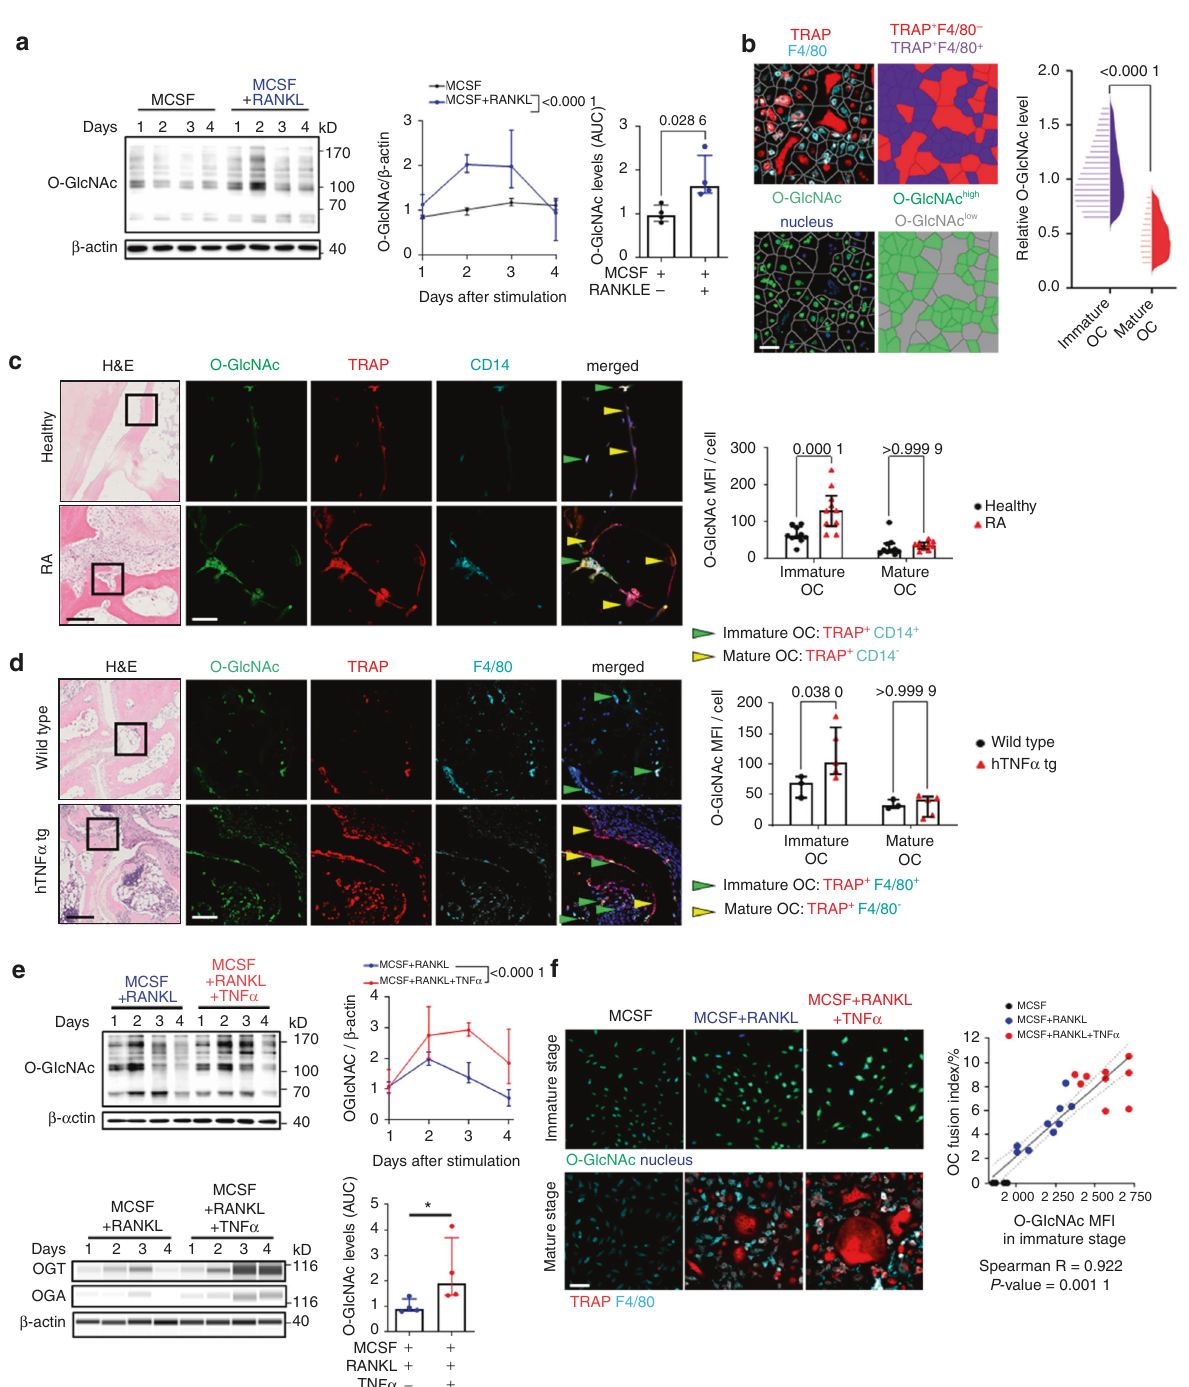
Fig. 1 Dynamic regulation of protein O-GlcNacylation during osteoclastogenesis. a Western blot analysis of protein O-GlcNAcylation during osteoclastogenesis in vitro ( n = 4 per group). Representative images and quanti fi cation of the changes in the levels of O-GlcNAc normalized to β -actin over time are shown. b Representative Voronoi-tessellated cellomics images of in vitro osteoclastogenesis and cellomics analysis of O-GlcNAcylation levels in immature and mature osteoclasts (OC) ( n = 21025 cells in total). Representative histology and confocal microscopic images of O-GlcNAc, TRAP, and CD14 triple stainings in bone tissues from healthy donors and RA patients ( c ) or wildtype and hTNF α tg mice ( d ). Semi-automated, blinded quanti fi cation of O-GlcNAcylation in immature and mature OC in synovial tissue sections ( n = 10 sections per group). Immature OC (green) and mature OC (yellow) are marked with arrows. e Representative blots of Western blots and ProteinSimple Wes immunoassay of O-GlcNAcylation, OGT, and OGA expression ( n = 4 per group). f Representative cellomics images of protein O-GlcNAcylation in immature OC and its correlation (Spearman) with osteoclastogenesis. The OC fusion index represents the proportion of the nuclei in mature OCs ( n = 9 per group). Bar graphs are shown as median ± IQR. Linear regression and its 95% con fi dence interval (dashed line) are presented in the correlation plots ( f ). Horizontal scale bars are represented as 50 µm in IF images or 200 µm in H&E images. Statistical signi fi cance was determined by Mann-Whitney U-test ( a, b, e ) or two-way ANOVA ( c , d ). P -values and Spearman ’ s ρ are shown in the graphs. AUC area under the curve, OC osteoclast, MFI mean fl uorescence